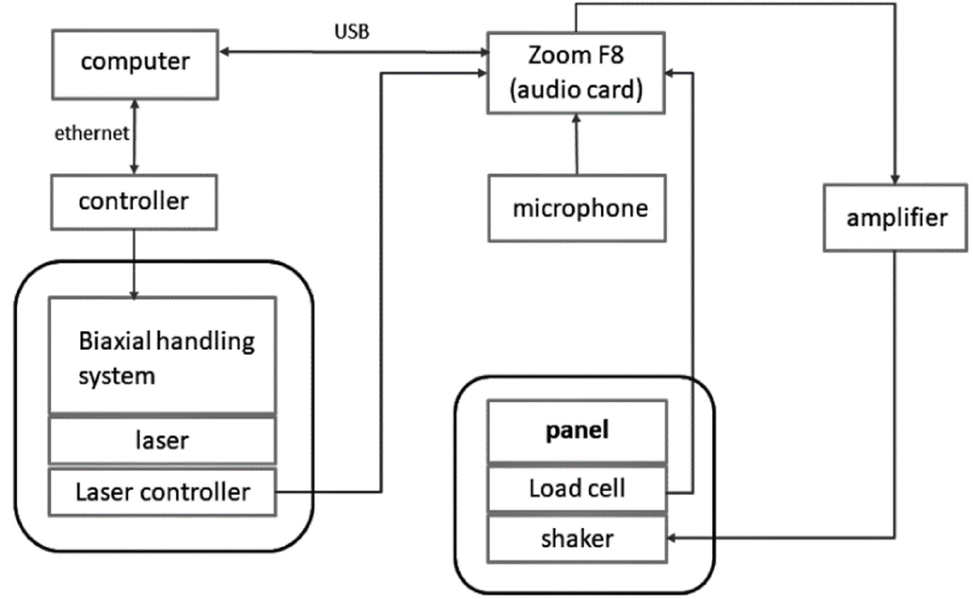
Figure 3. Block diagram of the experimental measurement setup.